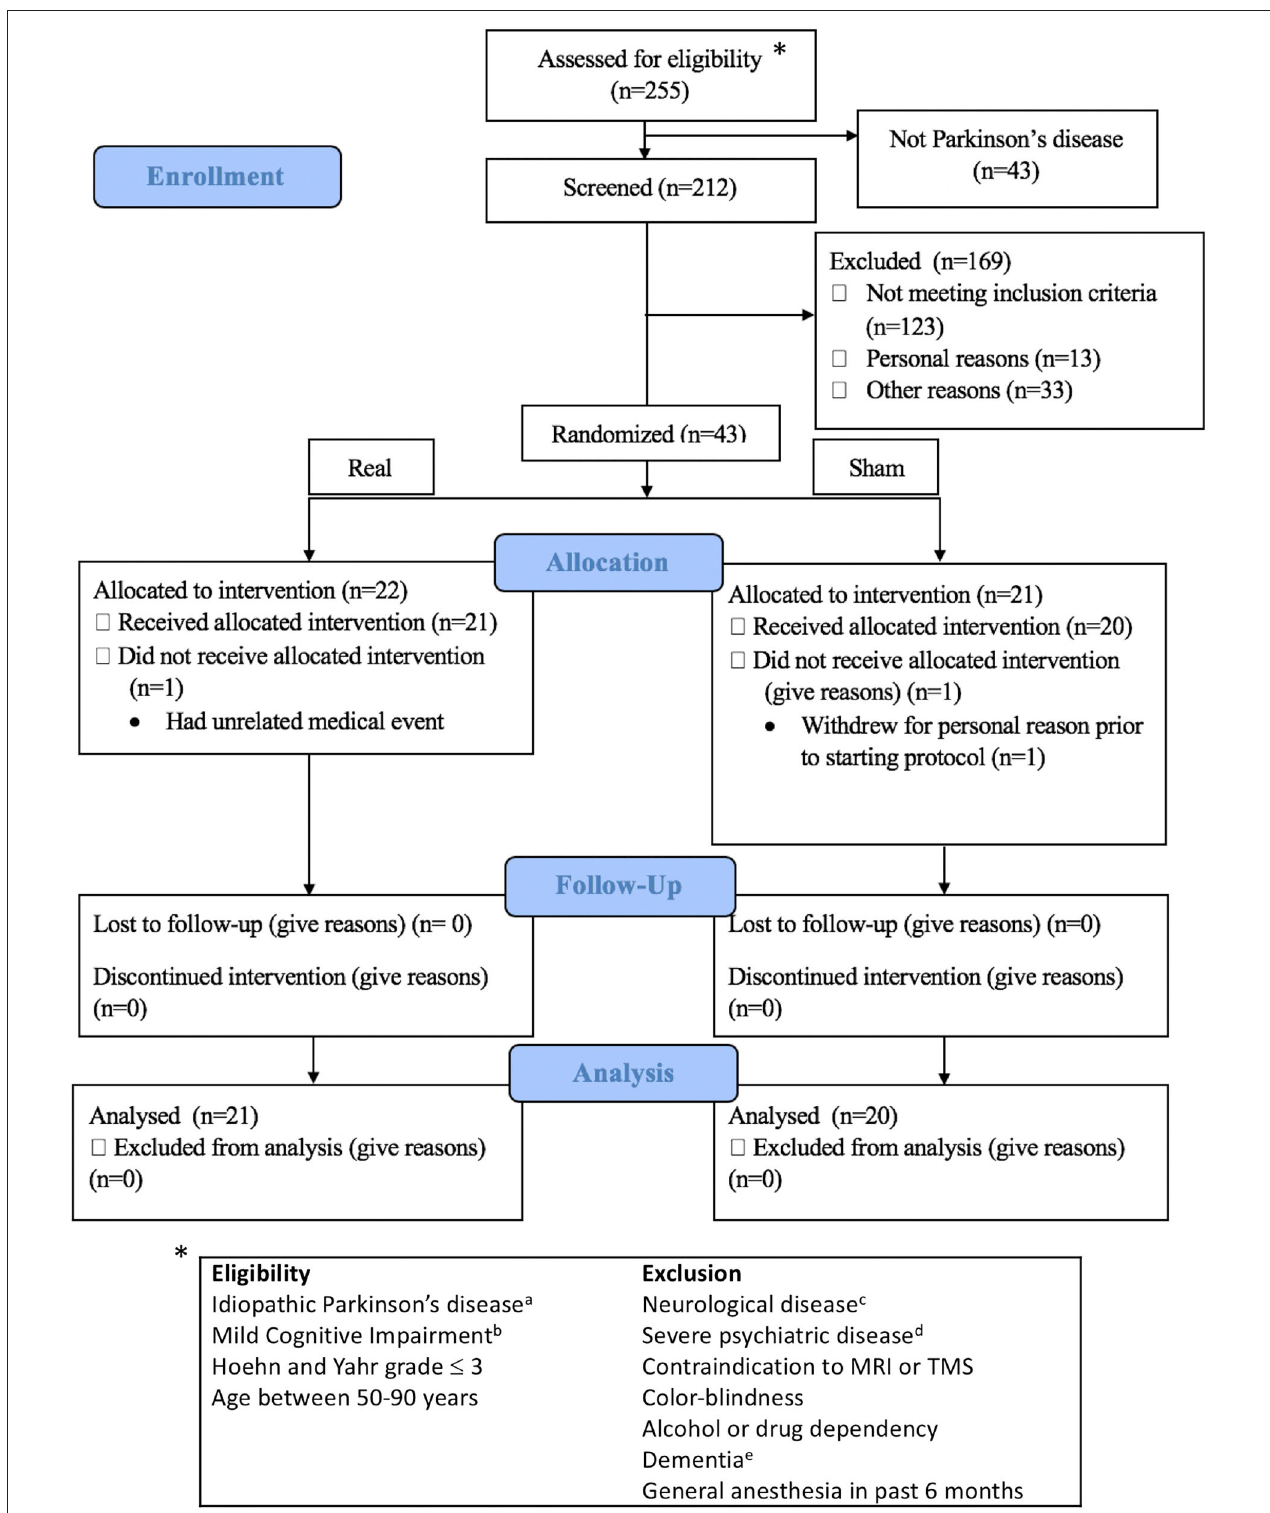
FIGURE 1 | Consort flow diagram and eligibility criteria. Exclusion details in Supplementary Methods I . a Diagnosed by a movement disorder neurologist; b Assessed according to MDS Task Force Level II criteria; c Other than idiopathic Parkinson’s disease; d Documented in the subjects’ clinical records by a physician; e Severe cognitive impairment affecting activities of daily living. *indicates to the eligibility criteria.